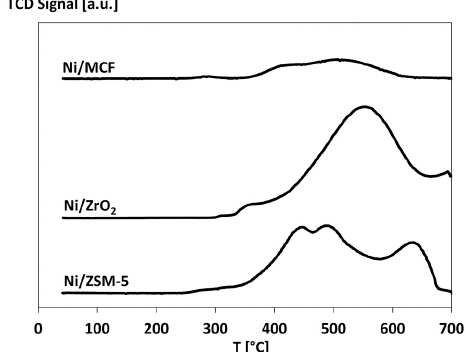
Figure 3. Temperature-programmed reduction (TPR) profiles of Ni catalysts.